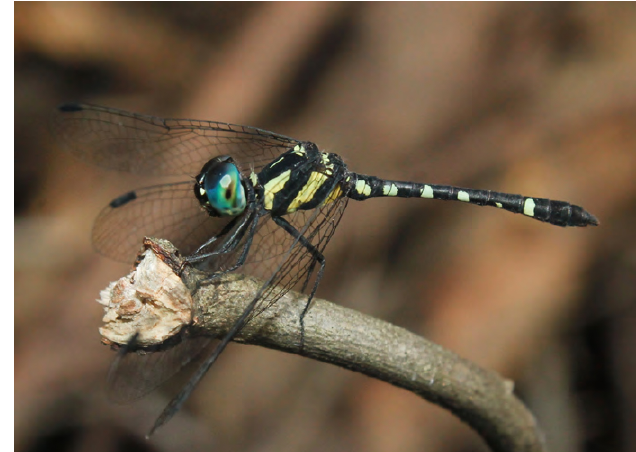
Figure 17. Tetrathemis yerburii ♂ . Figure 16. Distribution of Hylaeothemis fruhstorferi with new